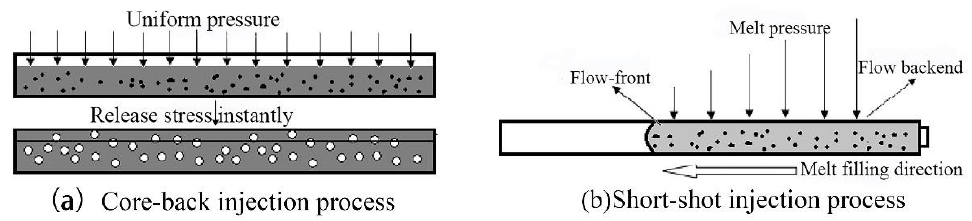
Figure 12. Schematic diagram of the pressure release force of melt in ( a ) the core-back injection process, ( b ) the short-shot injection process.